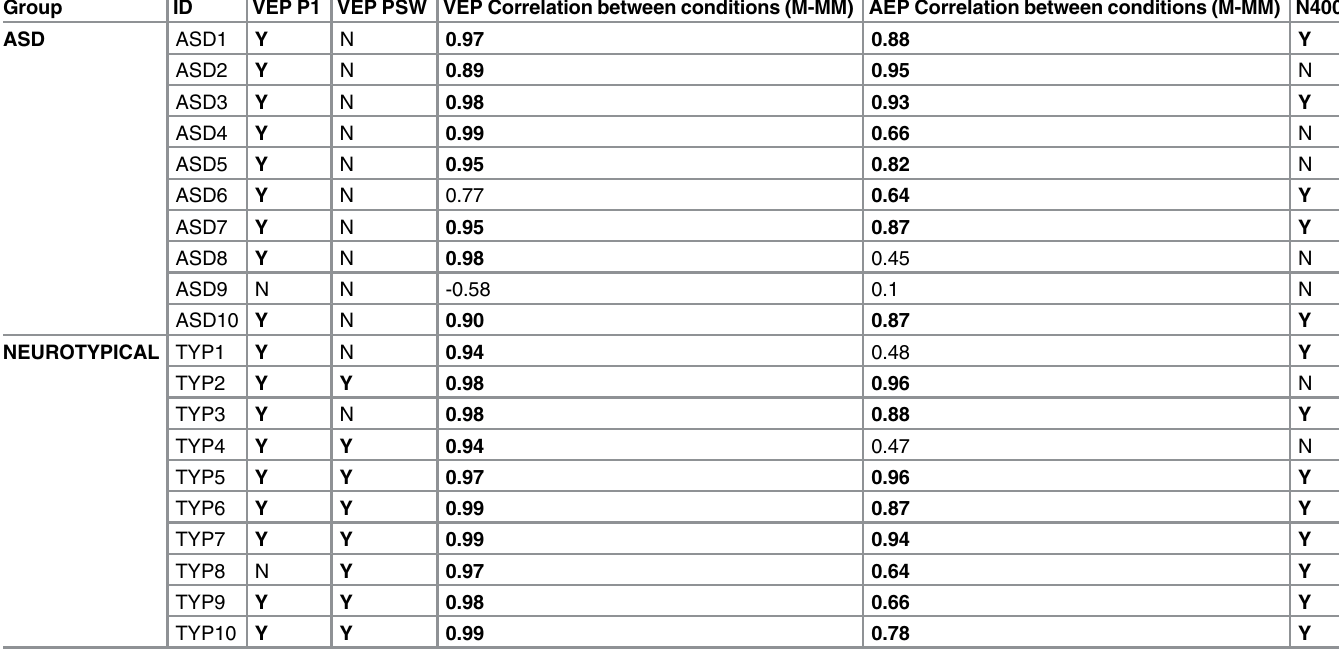
Table 4. Summary of individual ERP profiles.